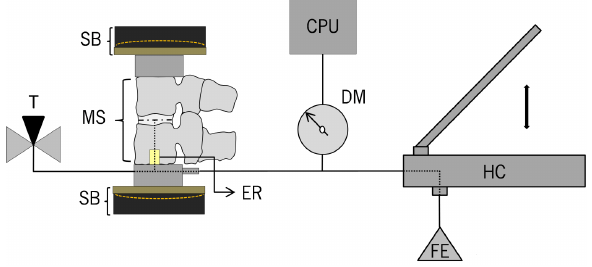
Figure 2. Failure pressure tester. The apparatus is composed by: